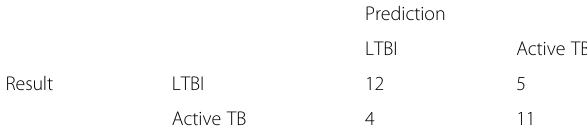
Table 2 Diagnosis using miRNA information